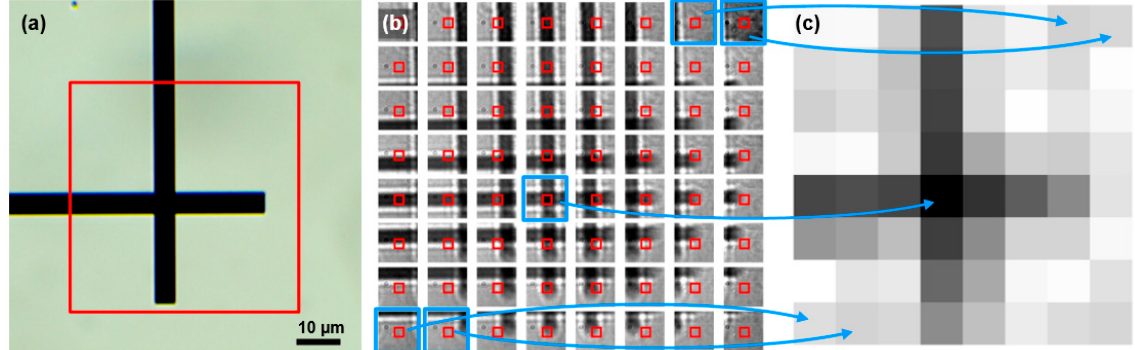
Figure 6. Transmission image reconstruction of the intersection of two lines of 5 µm width using the Led1 and MT9V024 image sensor as a light collector. The sensing area used was 9 × 9 pixels. ( a ) Optical image of the intersection of two lines of 5 µm width with the observed area highlighted in red. ( b ) Composition of the different raw shadow images generated by each micro-LED with the sensing area highlighted in red. ( c ) Reconstructed transmission image using the spatially resolved illumination.